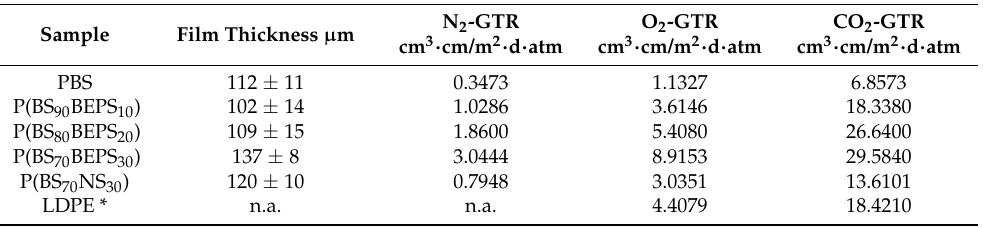
Table 5. Gas transmission rate (GTR) data for PBS, P(BS m BEPS n ) and P(BS 70 NS 30 ) random copolymers, normalized for the thickness film sample, at 23 °C, with N 2 , O 2 and CO 2 dry gas test.